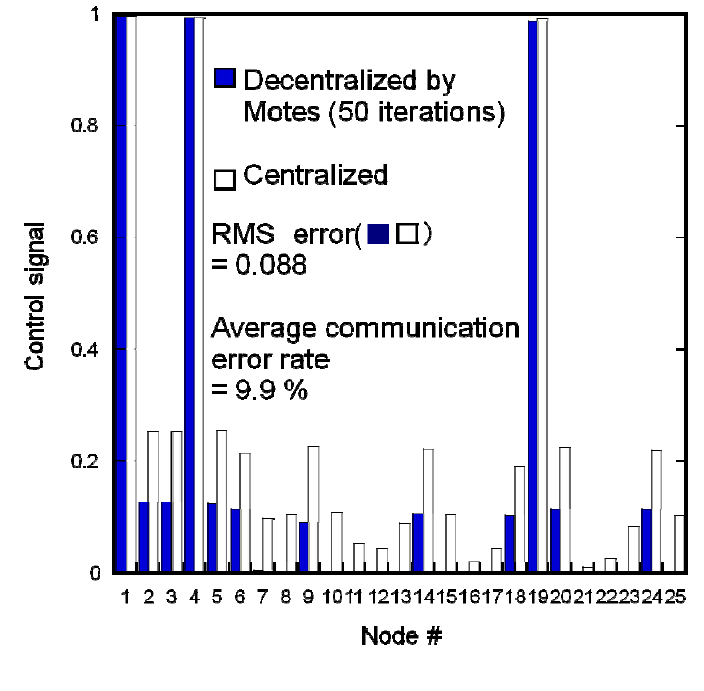
Figure 8. Experimental results of distributed actuation using Motes implemented with decentralized algorithm and simulation of centralized algorithm. The decentralized algorithm is based on the penalty function